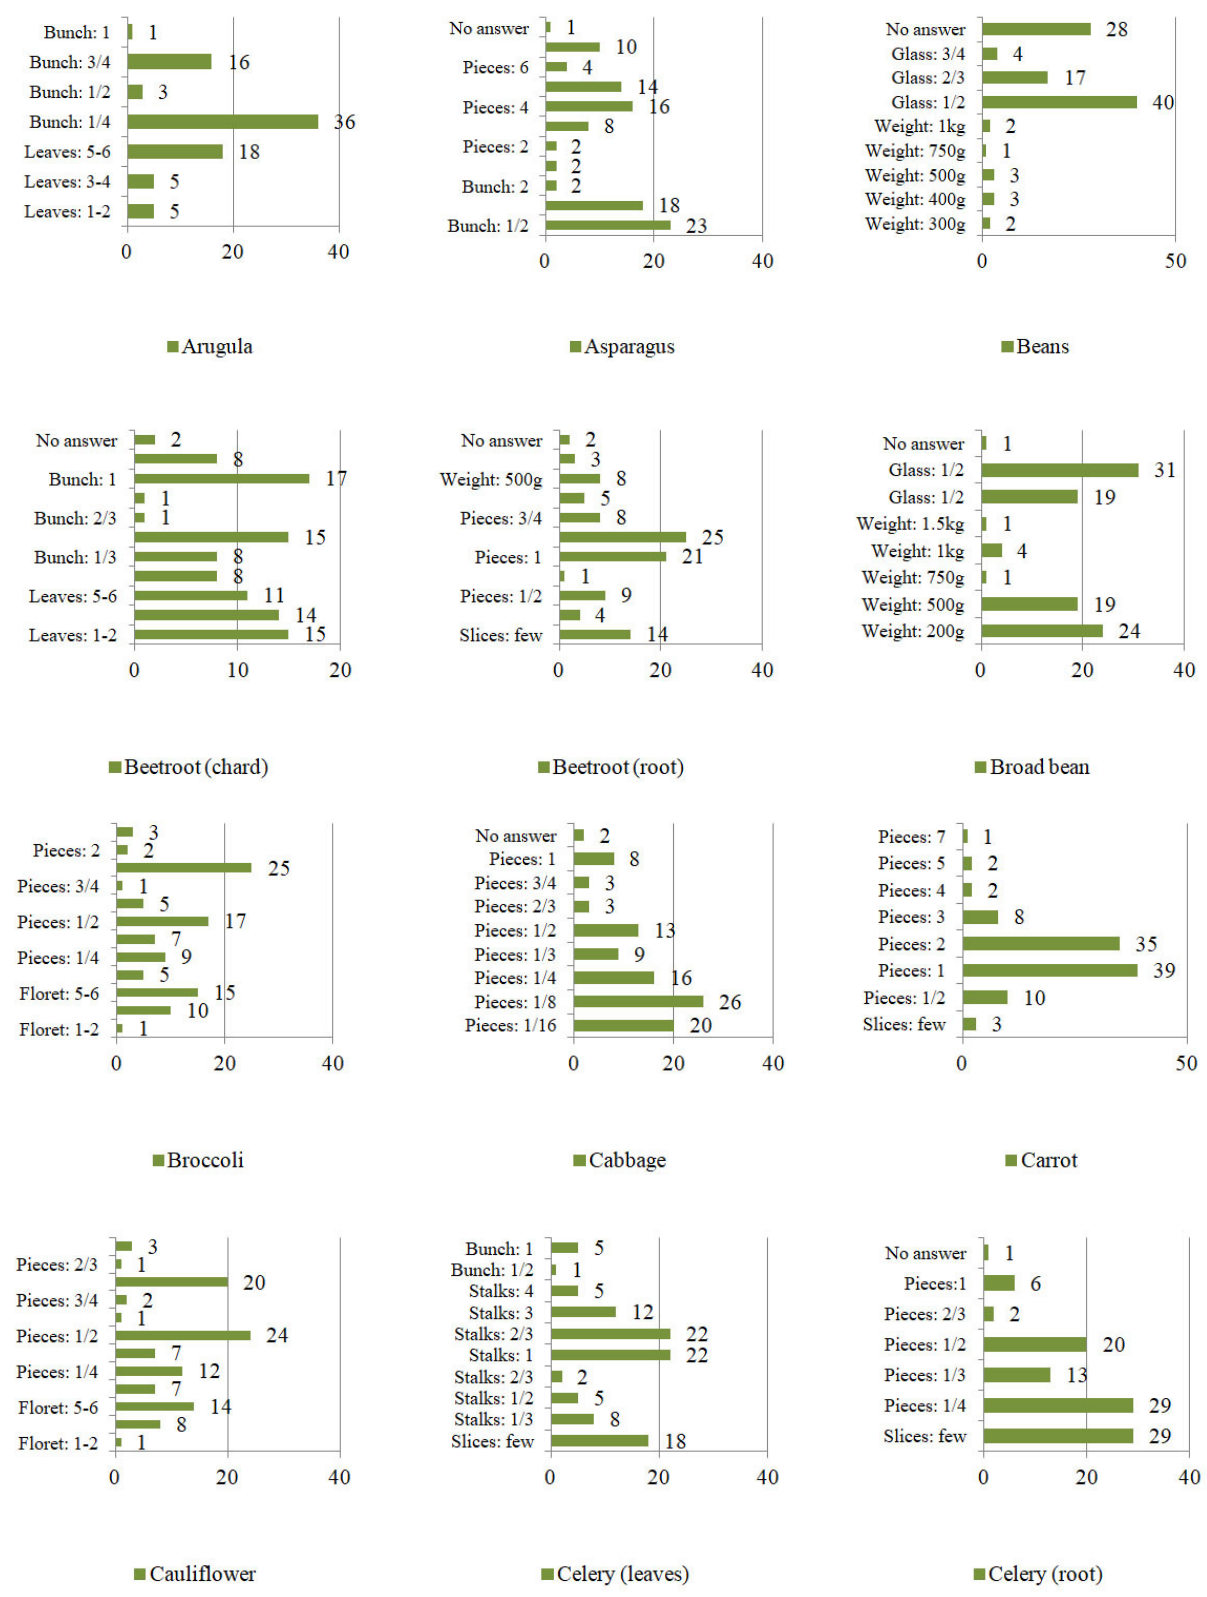
Figure 7. The quantity of vegetables consumed at one sitting by Poles [%].